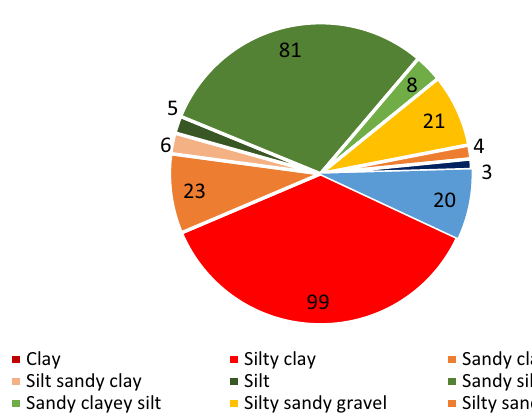
Fig. 8 Proportion of non-clay embankment material